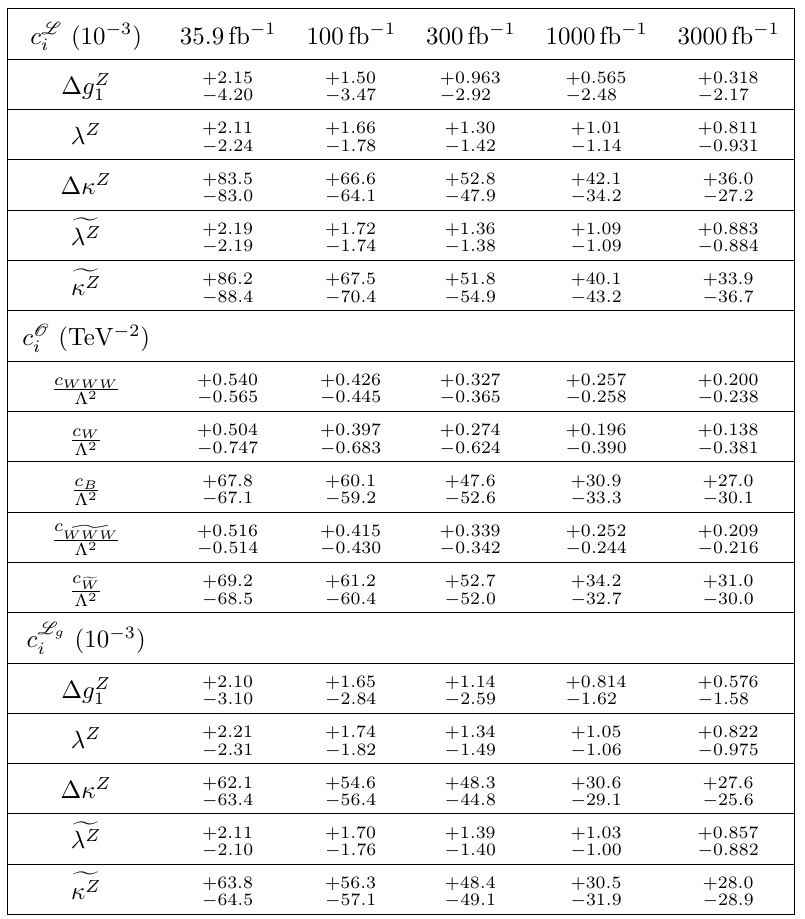
Table 5 . The list of simultaneous limits from MCMC at 95 % BCI on the e(cid:11)ective vertex couplings c L and the e(cid:11)ective operator couplings c O i various luminosities with the notation higher limit